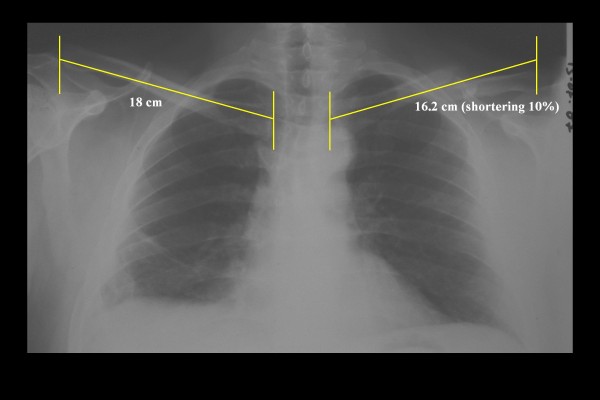
Radiographic image of the clavicle of a dissatisfied patient after conservative treatment of a diaphyseal clavicle fracture. The observed shortening was 18 mm or 10%; the Constant score was 65.